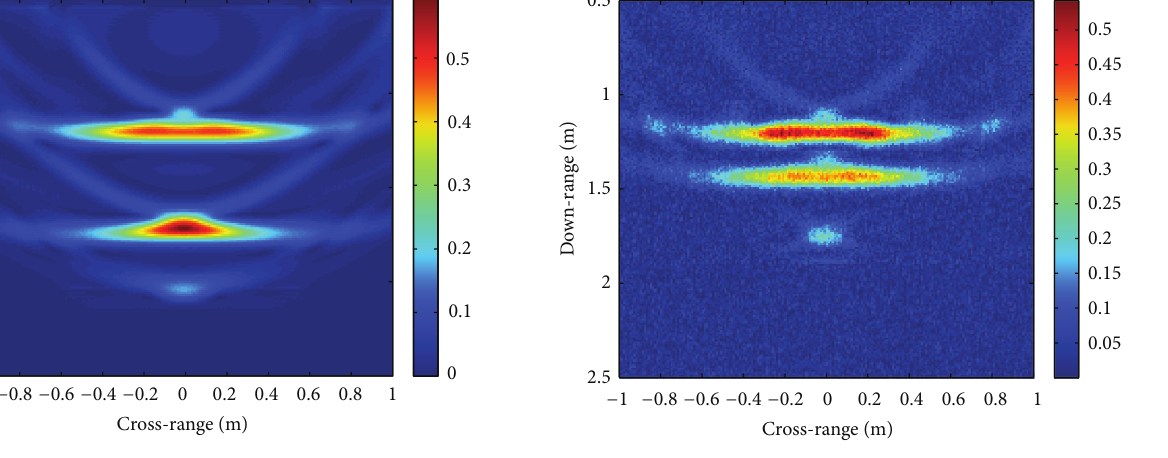
Figure 4: Imaging result using traditional imaging method. Figure 5: Imaging result of proposed method with SNR = 10 dB. Table 1: Mean value of the estimated wall parameters in different